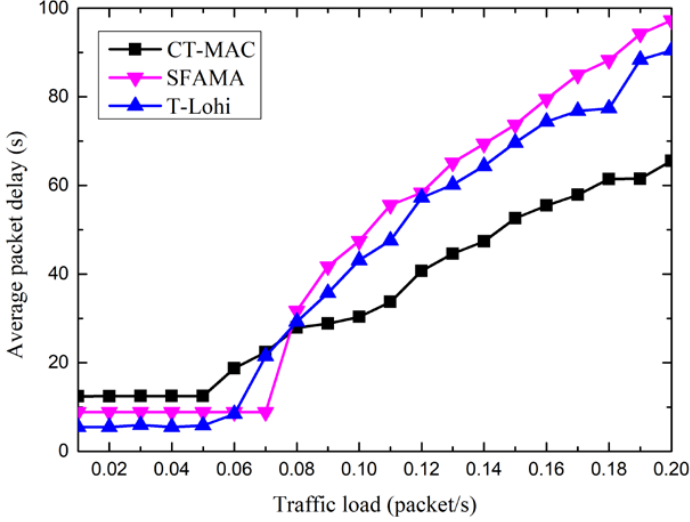
Figure 12. The average packet delay of the CT-MAC protocol in sub-topology.